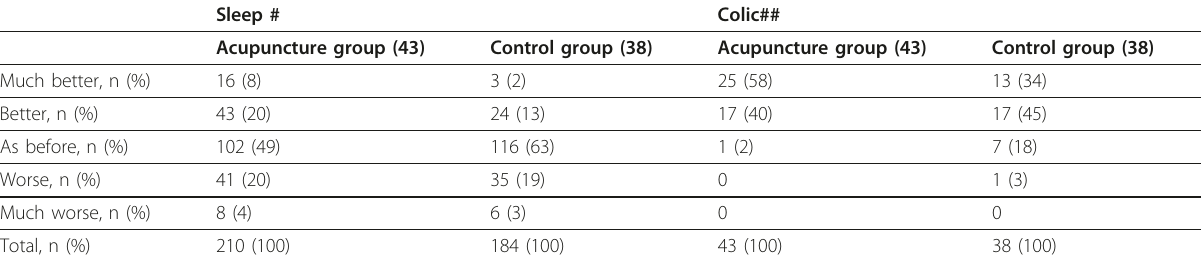
Table 4 Changes in sleep and development of colic during the three intervention